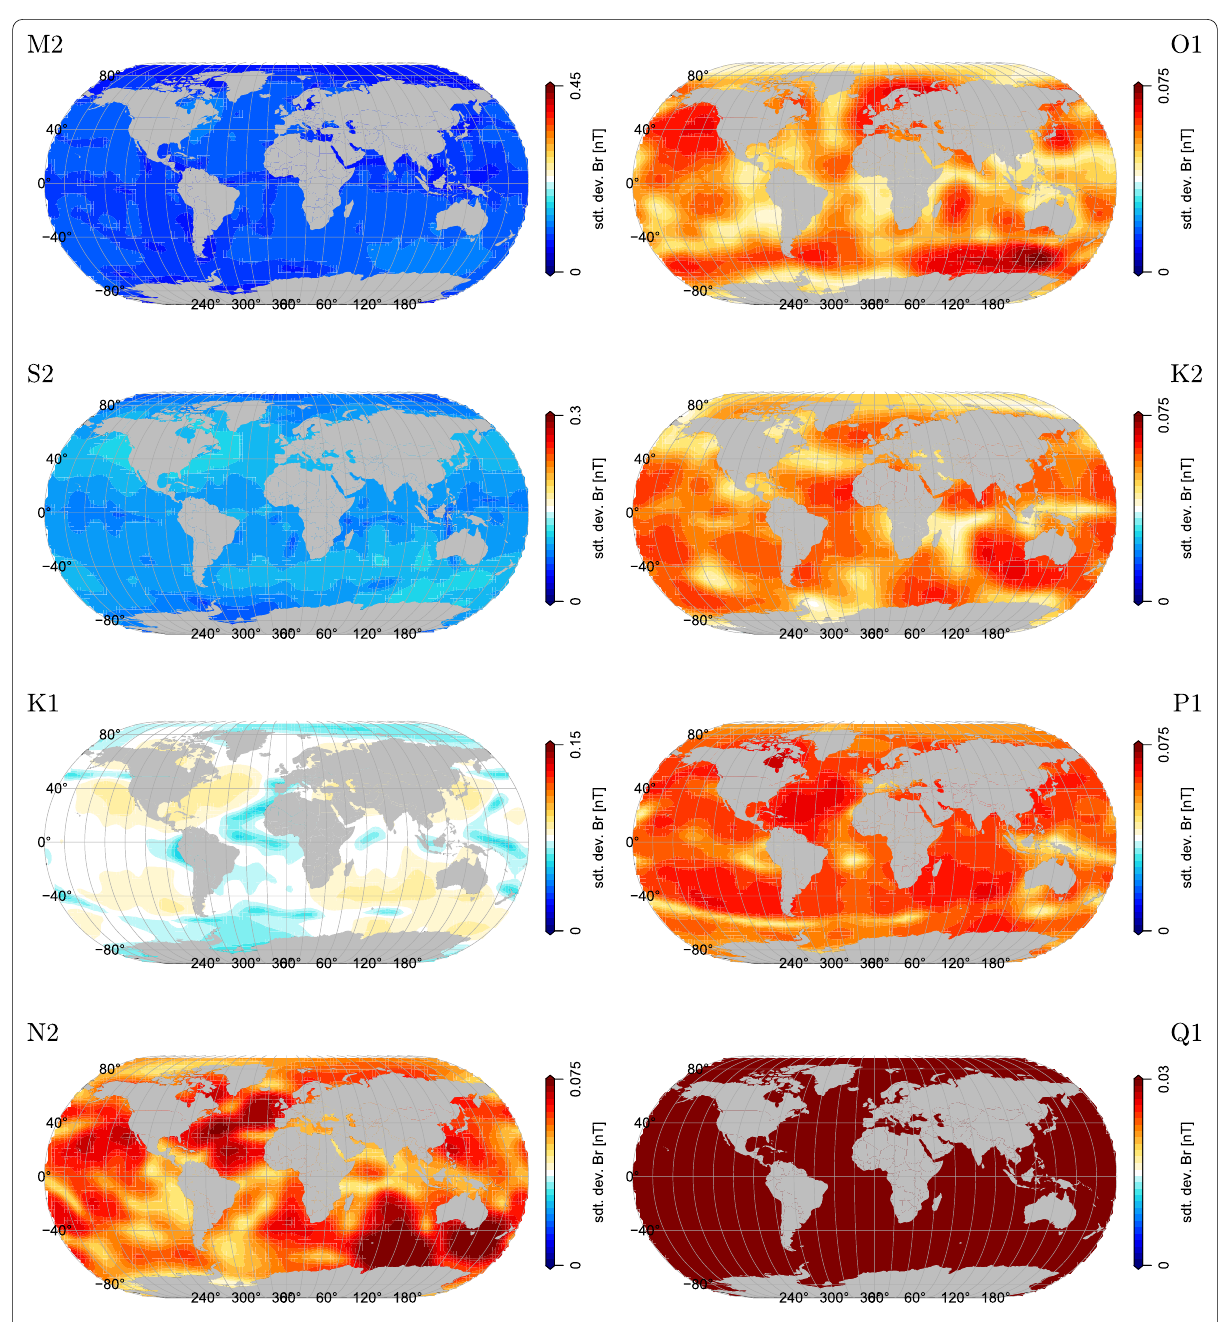
Fig. 4 Standard deviation of posterior errors of the tidal radial magnetic fields as estimated by the KALMAG Kalman filter. Left column: M2, S2, K1, N2. Right column: O1, K2, P1, Q1. All fields are represented at the satellite height of 430 km above sea level. Please note the different color bar